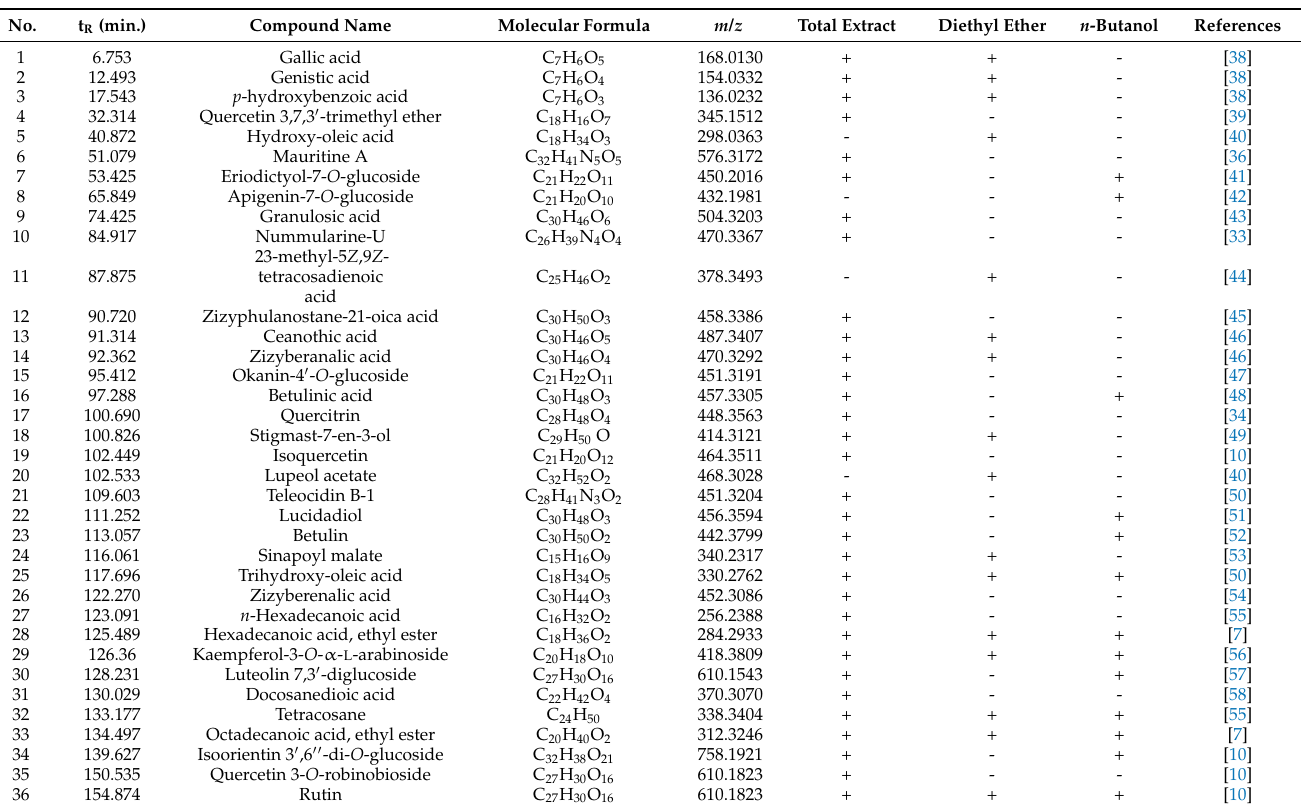
Table 3. The LC-HRESIMS metabolite profiling of Zizyphus spina-chritis L. stem bark different fractions (Total ethanol extract, diethyl ether, n